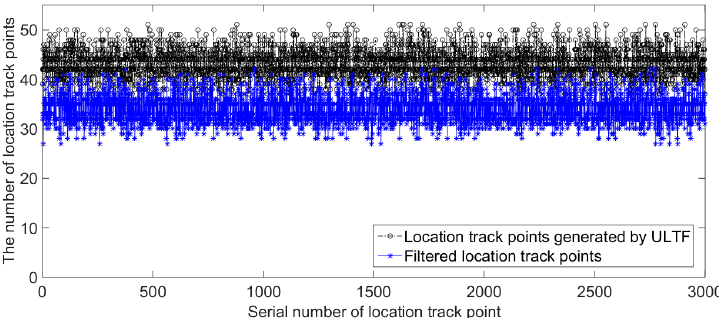
Figure 13. Quantitative comparison of filtered location track points after tunnel environment changed.